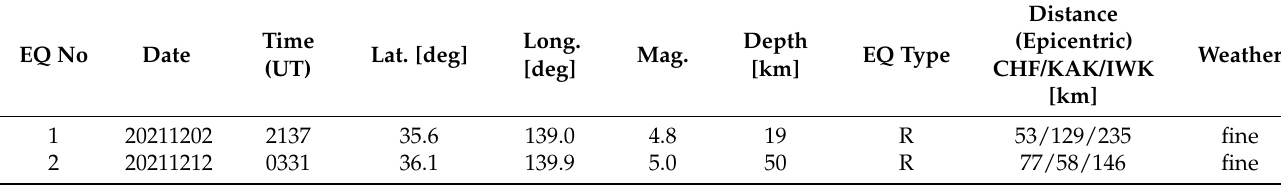
Table 1. Parameters of two EQs selected for this study.